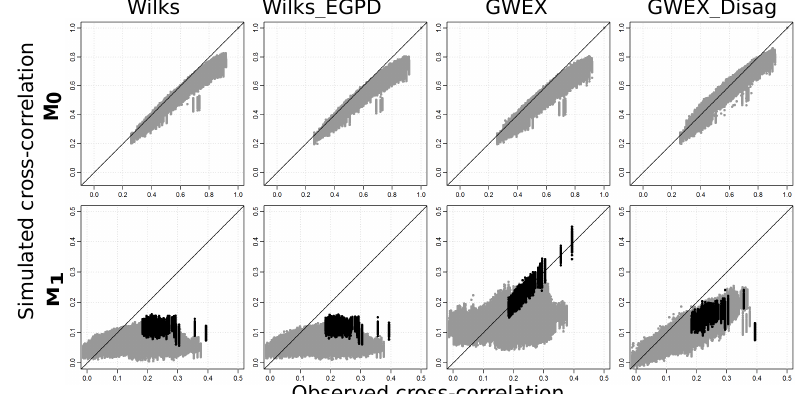
Figure 10. Comparison of unlagged inter-site correlations ( M 0 ) and lag-1 inter-site correlations ( M 1 ) in observed and simulated precipitation series, for the winter (DJF) and summer (JJA) seasons and for the different model versions considered. Black points indicate lag-1 serial autocorrelations at the stations.